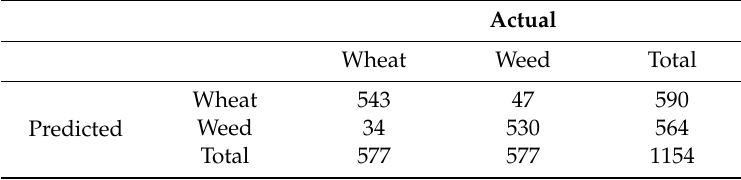
Table 4. Confusion matrix of classification by the SVM-RBF